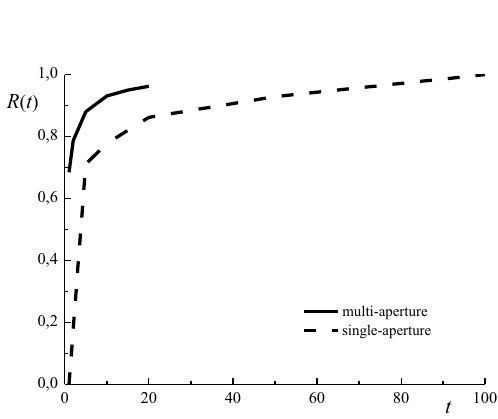
Figure 4. The coefficient of correlation between reconstructed and non-distorted images as a function of the number of short-exposure frames for multi- and single-aperture systems. Thus, we can conclude that the use of multi- Figure 3. Reconstructed image of a periodic aperture observation systems for computer harmonic object in the case of an array of 64 correction of atmospheric distortions in an subapertures for the number of short-exposure anisoplanar turbulence can significantly reduce = 1 (a), 2 (b), 5 (c), and 20 (d) realizations N the exposure time (accumulation of short- SE used for the image synthesis. exposure images) when synthesizing isoplanar distorted images. Main distortions are well corrected when synthesizing images for a short exposure time, which corresponds to a “frozen” turbulent medium. The time required for the correction of residual small-scale distortions is an order of magnitude shorter than in the case of synthesizing long-exposure images using a single- aperture observation